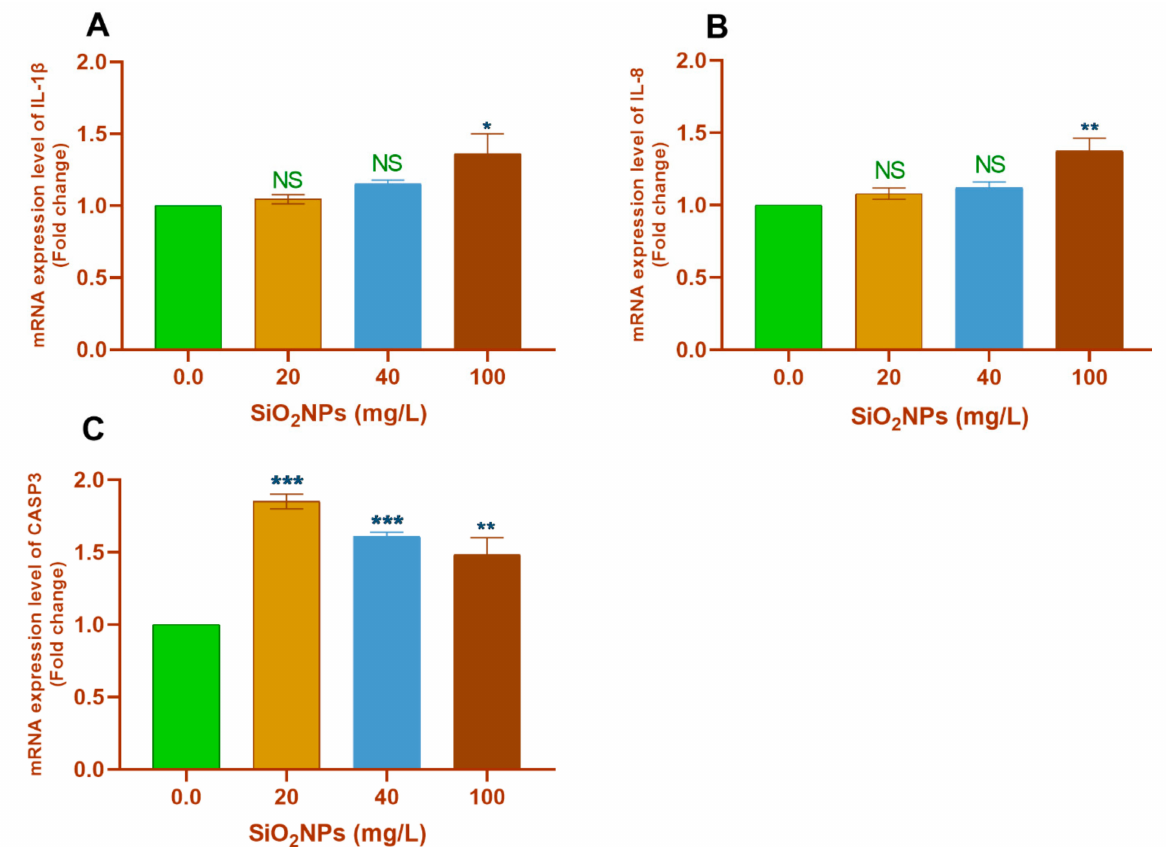
Figure 3. Transcription profile of the ( A ) IL-1 β , ( B ) IL-8 , ( C ) CASP3 genes in gills of Nile tilapia juveniles after exposure to different concentrations of SiO 2 NPs (0.0, 20, 40, and 100 mg/L) for 21 days. The values are expressed as mean ± SEM ( n = 9). Asterisks (*) ( p < 0.05), (**) ( p < 0.01), and (***) ( p < 0.001) indicate significant differences between the exposure groups compared with the control group. NS indicates non-significant